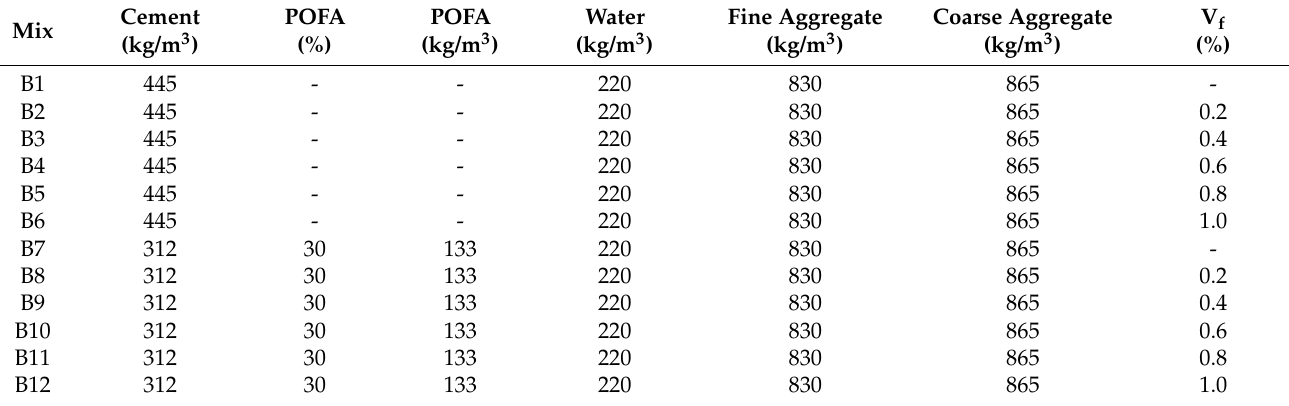
Table 3. The proportions of the different concrete